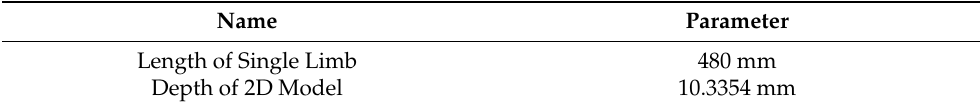
Table 1. The parameters of the simulation model.